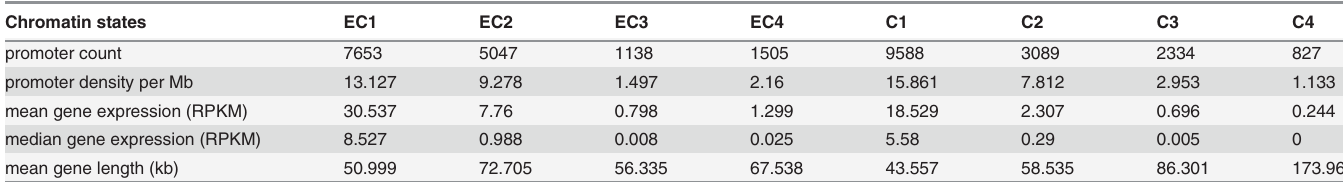
Table 2. Gene content in the four prevalent chromatin states of H1hesc and K562 cell lines. Chromatin